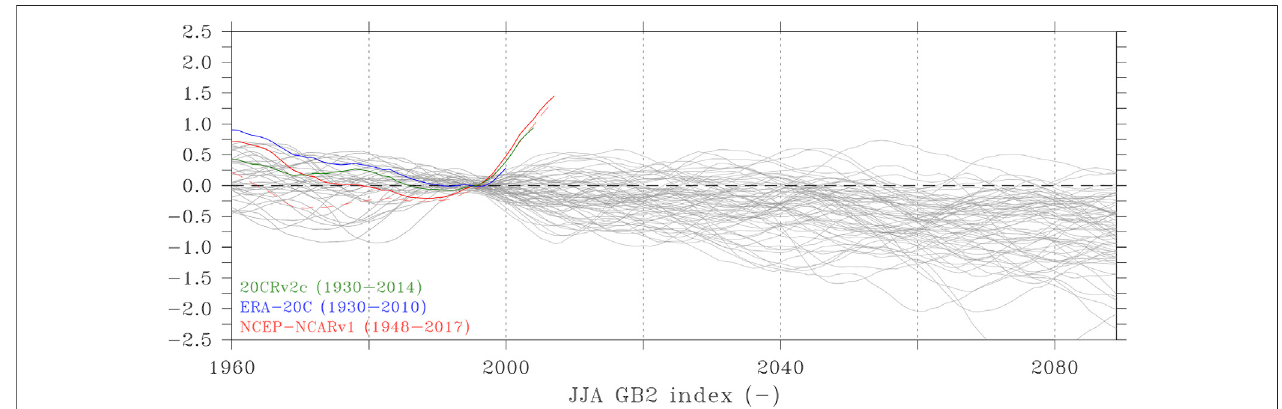
FIGURE 4 | Time series of June, July and August Greenland Blocking Index 1 (dashed red line) and Greenland Blocking Index 2 (solid red line) indices over 1950 – 2,100 as simulated by NCEP/NCAR Reanalysis 1 (red line), by 20CRv2c reanalysis (green line), and by ERA-20C reanalysis in blue as well as by all the CMIP5 models (gray lines) for which both RCP4.5 and RCP8.5 scenarios are available. For the CMIP5-based time series, the historical scenario is used over 1900 – 2005 and both RCP4.5 and RCP8.5 afterward. A 20-years running mean has been applied to smooth the time series, and values have been normalized (average (cid:1) 0 and standard deviation (cid:1) 1) using 1986 – 2005 as the reference period, from Hanna et al.